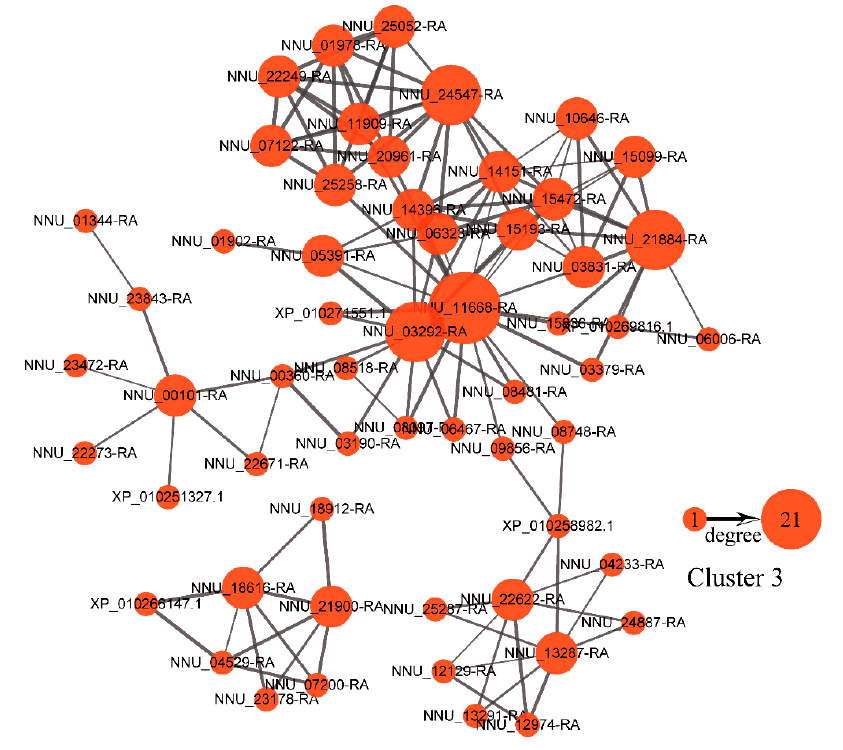
Figure 6. Protein-protein interaction (PPI) network of the proteins in cluster 3: The edge numbers of the proteins range from 1 to 21.